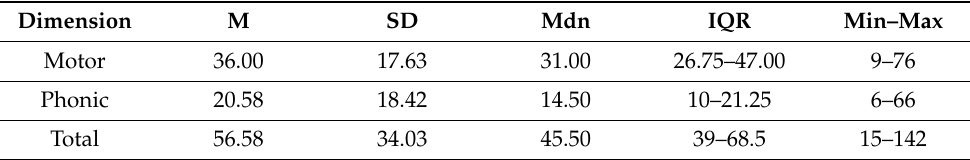
Table A10. Scores in the Adult Tic Questionnaire (ATQ) of patients with TS ( n = 12). Abbrevi- ations: IQR, interquartile range; M, mean; Max, maximum; Mdn, median; Min, minimum; SD, standard